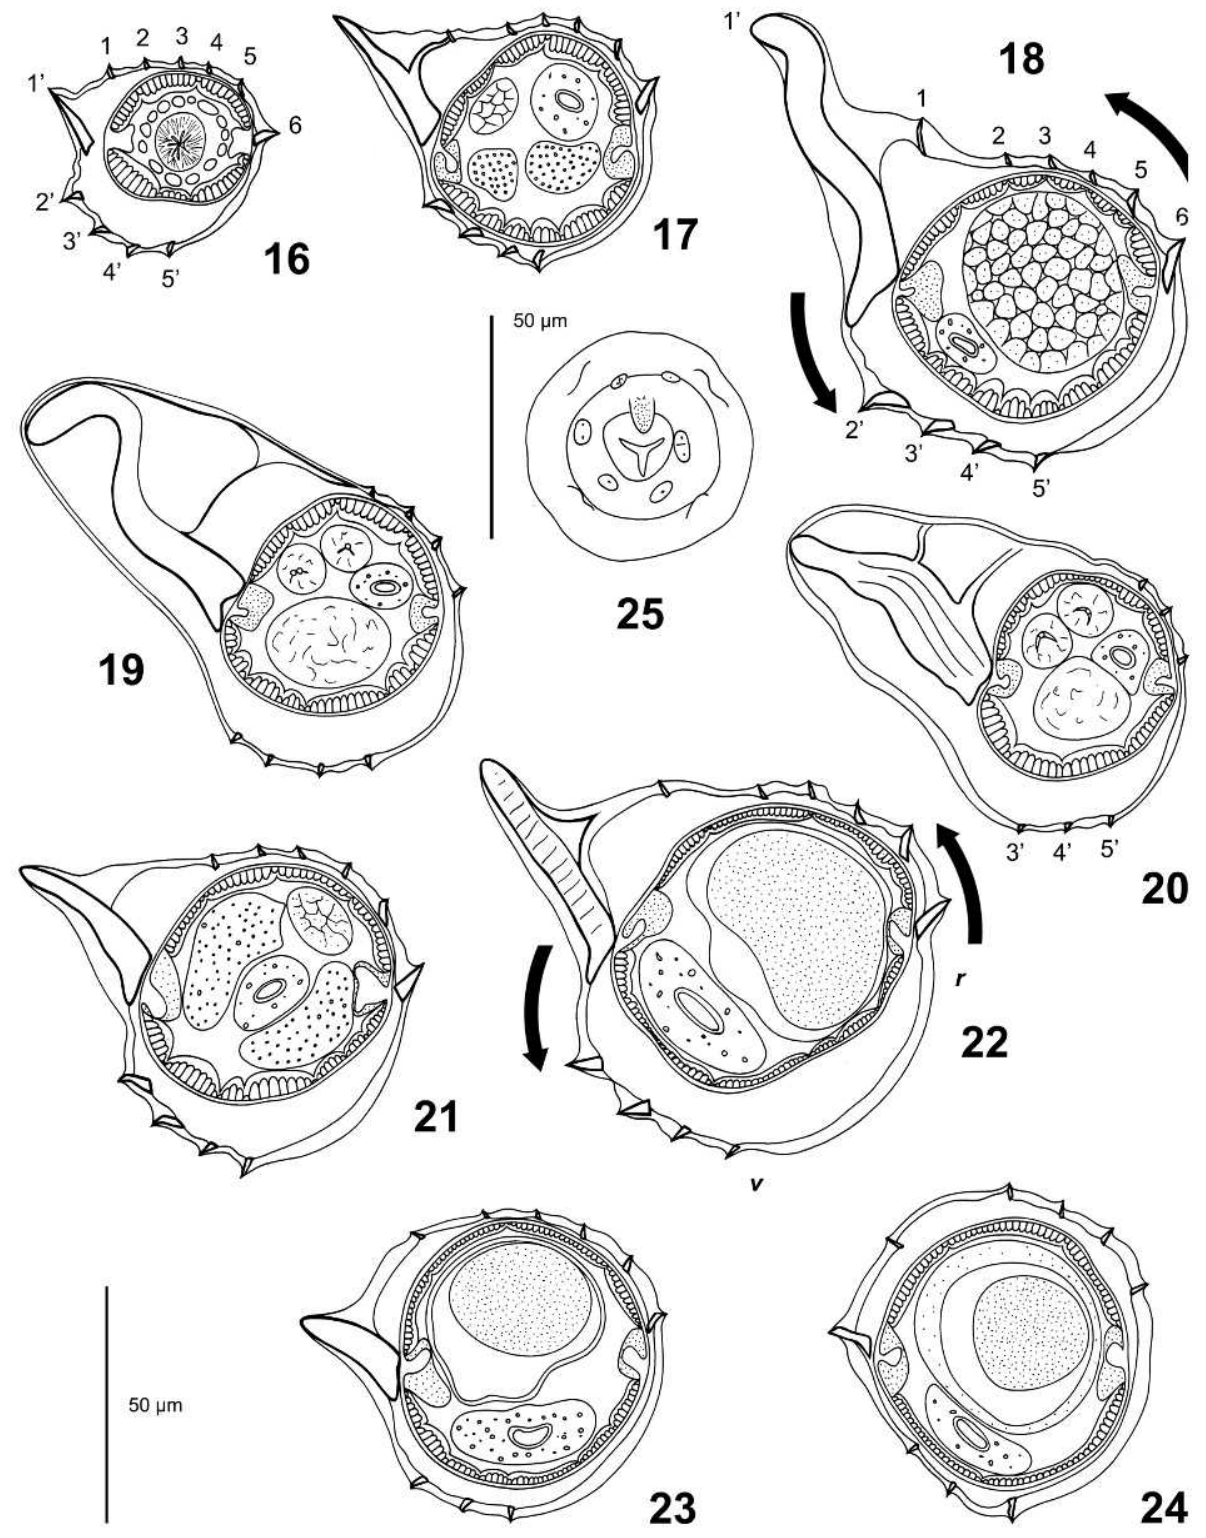
All sections are orientated as 22. Abbreviations: v: ventral side, r: right